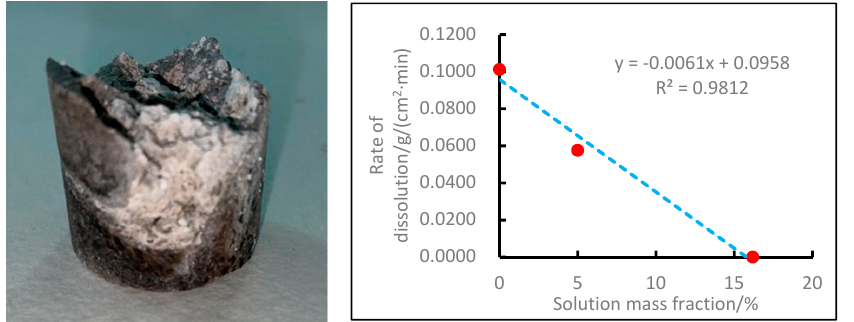
Figure 4. Dissolution of cores in solutions of different concentrations. ( Left ) salt − dissolved morphol- ogy of fracturing fluids containing 5% sodium bicarbonate; ( Right ) Influence curve of solution with a different salt concentration on dissolution rate.